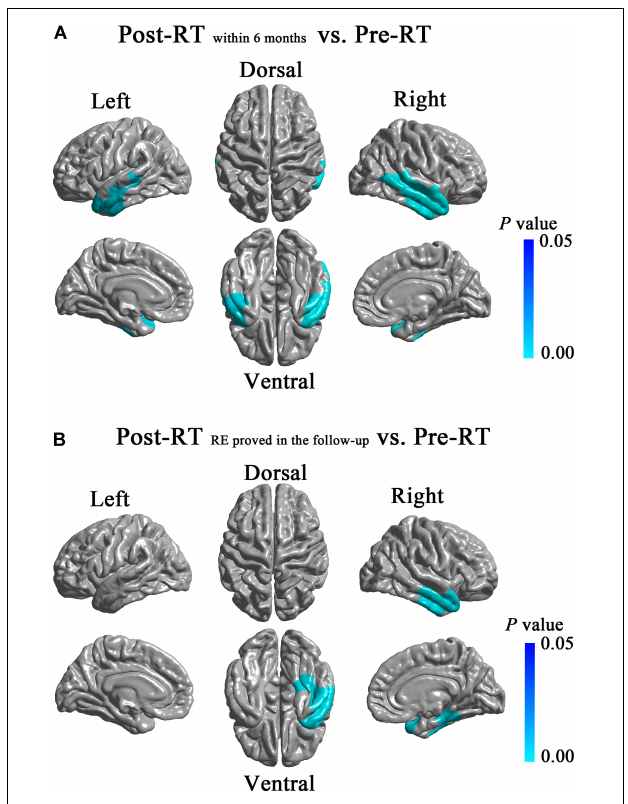
FIGURE 2 | Between-group differences in cortical thickness. Compared with the Pre-RT group, patients in the Post-RT within6 months group showed significant cortical thinning in the bilateral lateral temporal lobes, including the bilateral TP, bilateral inferior, middle and superior temporal gyrus (A) . Compared with the Pre-RT group, patients in the Post-RT REprovedinfollow - up showed significant cortical thinning in the right dorsal and ventral anterior temporal lobe, including the TP, inferior, middle and superior temporal gyrus, parahippocampal gyrus, and fusiform gyrus (B) . Colored areas denote regions where a significant difference in cortical thickness was observed between the indicated groups. Differing hues within each colored area denote statistical confidence in the observed differences expressed as P -value, according to the attached P -value color scale.